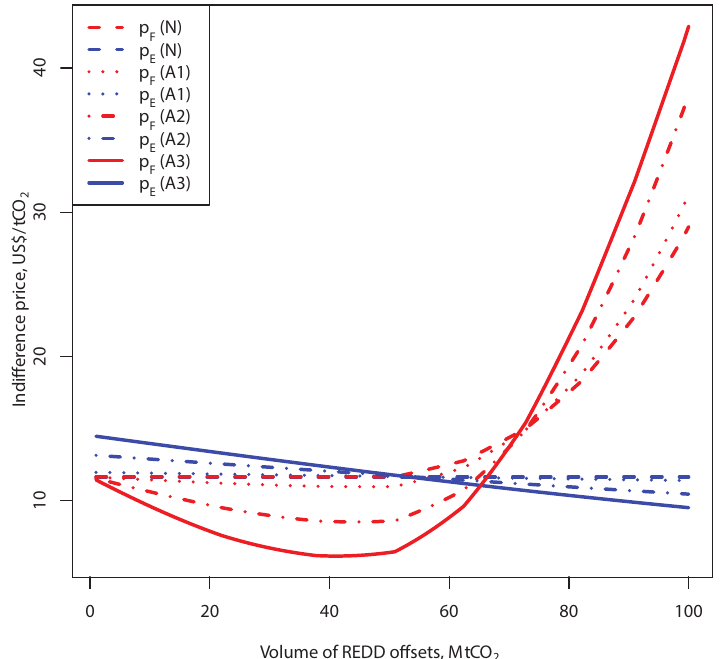
Figure 3. Indifference prices in the FI-REDD model with flobsions. Comparison of risk-neutral case (N) with risk-averse cases: A1, A2 and A3, for benefit-sharing parameter δ = 0.5, strike price p min = 20 US$/MtCO 2 , CO 2 distribution (19) and opportunity cost (20) with K = 0.9. Blue curves correspond to indifference prices of the electricity producer and red curves of the forest